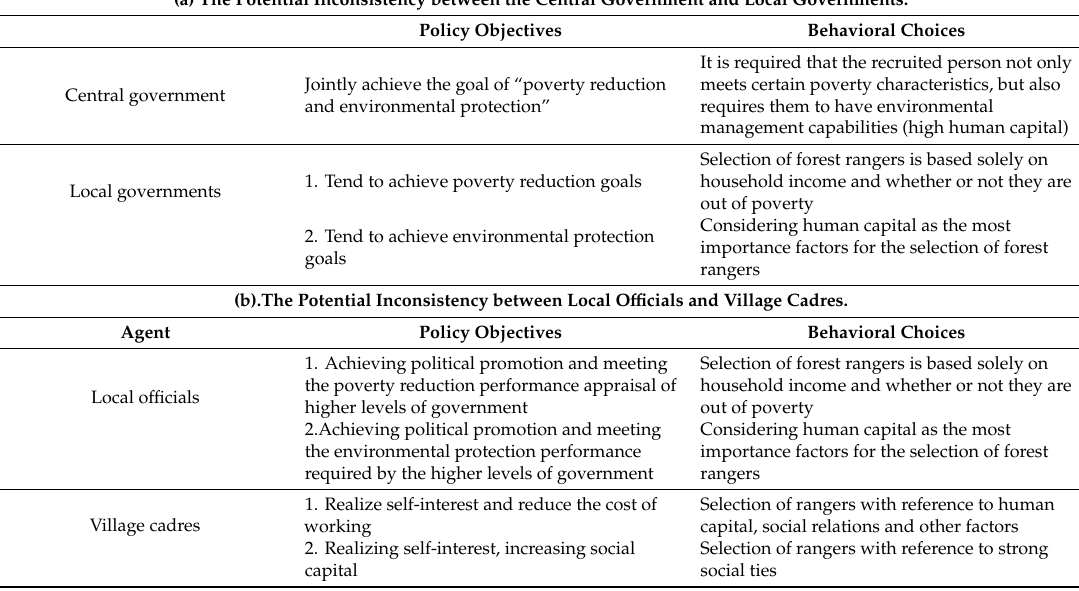
Table 3. ( a ) The potential inconsistency between the central government and local governments. ( b ) The potential inconsistency between local o ffi cials and village